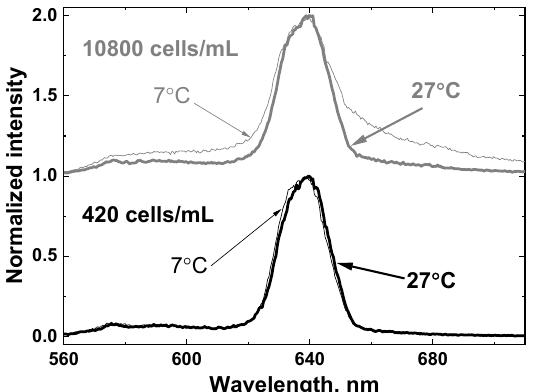
Figure 11. LiDAR spectra of two samples with minimal and maximal algae concentration: 420 cells/mL (lower panel) and 10800 cells/mL (upper panel) at low and high temperature (7 and 27 °C). The spectra are shifted vertically for better view.